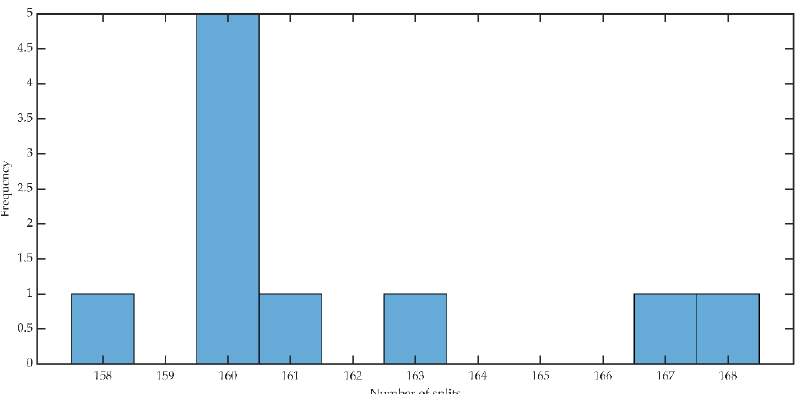
Figure 14. Histogram of the number of splits on the cross-validated shallow regression tree model for the prediction of thermal energy production.